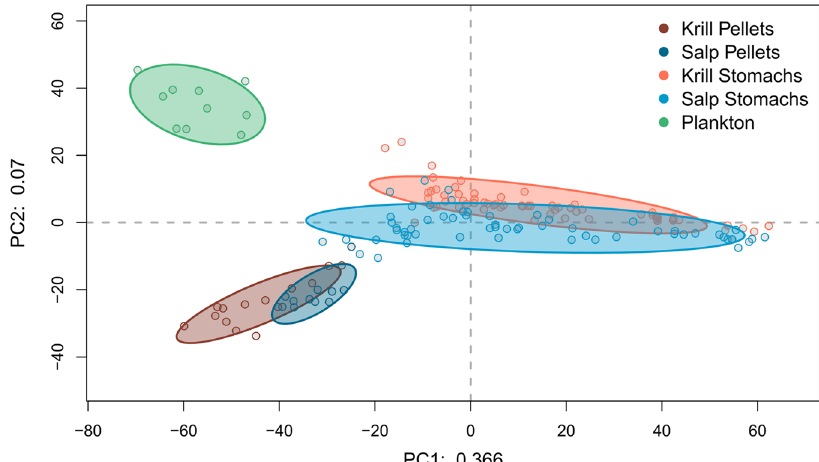
Fig. 2 Principal component analysis (PCA) of the 18S metabarcoding libraries. The PCA shows the re fi ned, centered-log-ratio transformed dataset containing 156 samples with each dot representing an individual sample. Ellipses are drawn around the fi ve pre-de fi ned sampling groups krill fecal pellets (dark red), salp fecal pellets (dark blue), krill stomach content (light red), salp stomach content (light blue), and the ambient plankton community (green) with a con fi dence interval of 75%. The explained variation in decimals for the fi rst two principal components (PC) is shown on the x - and y -axis,